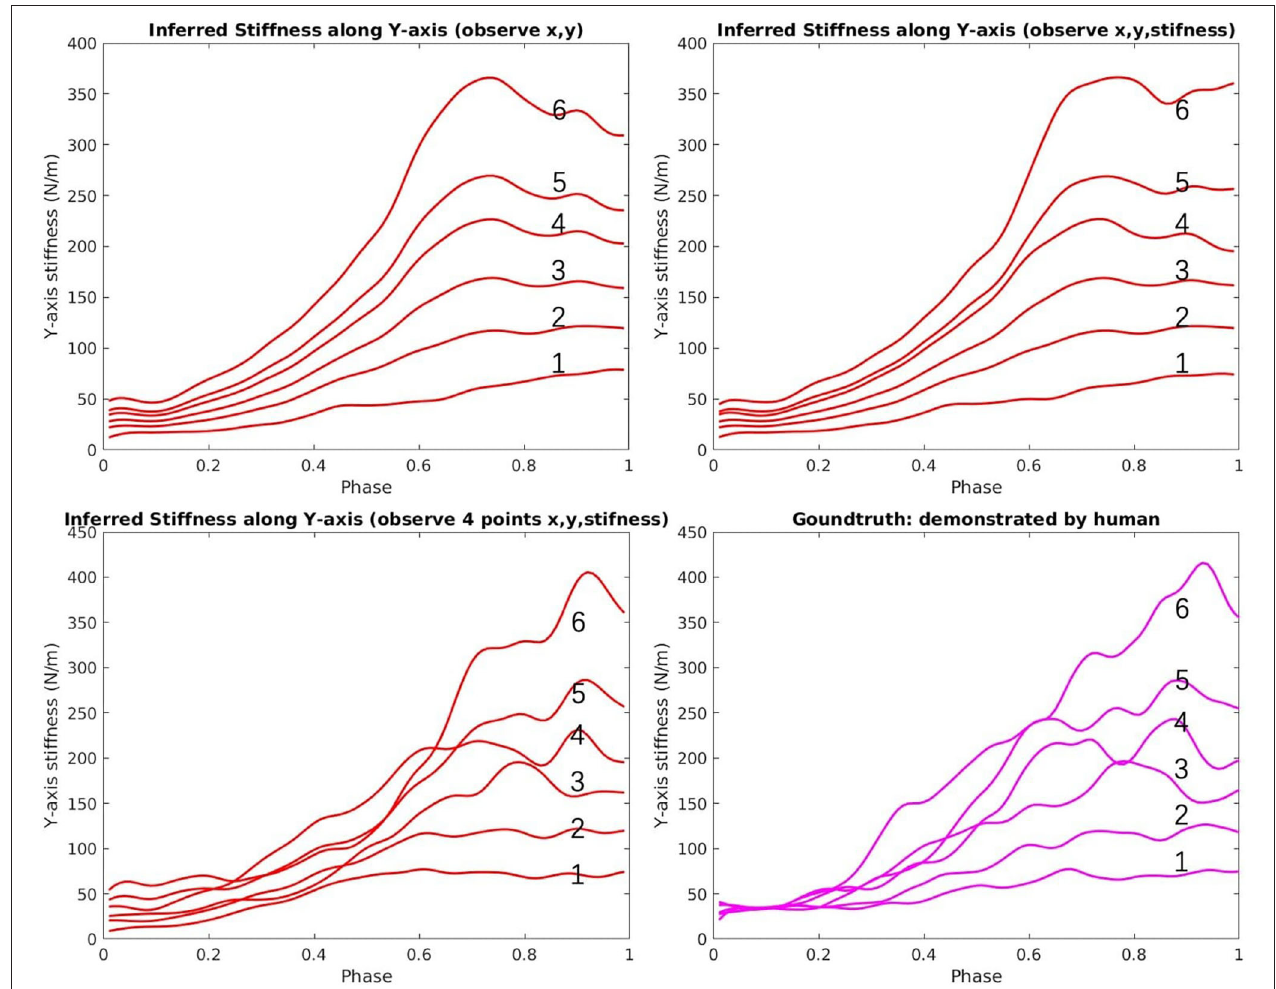
FIGURE 11 | The inferred stiffness along y-axis vs. the ground truth of the hand-over task [red (inferred)/magenta (recorded ground